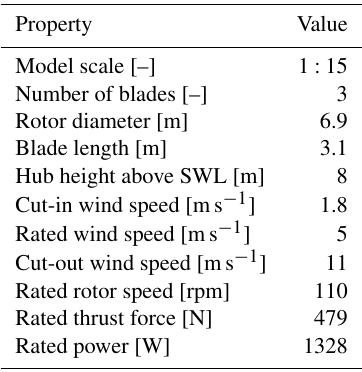
Table 1. Gross data about the wind turbine model.